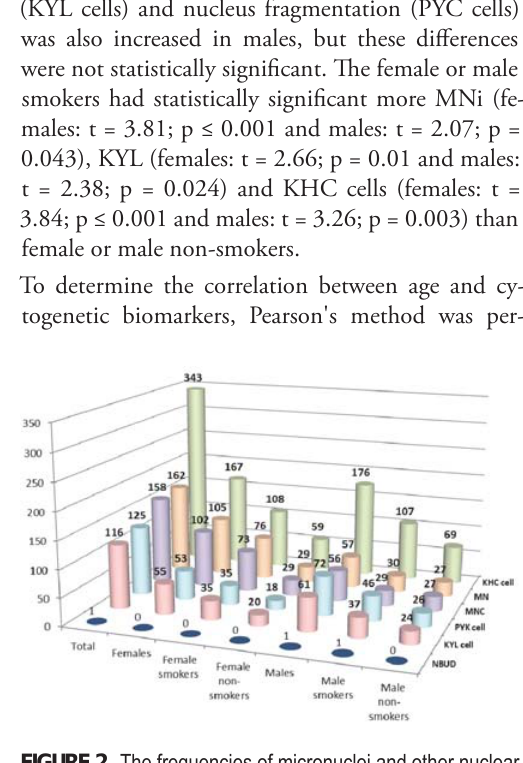
FIGURE 2. The frequencies of micronuclei and other nuclear alterations in exfoliated buccal cells of studied subjects. Aver- age cells scored per subject (per 1,000 cells). PYK, pyknotic; KYL, karyolytic; KHC, karyorrhectic; NBUD, nuclear bud; MNC, micronucleated cells; MN, micronucleus.